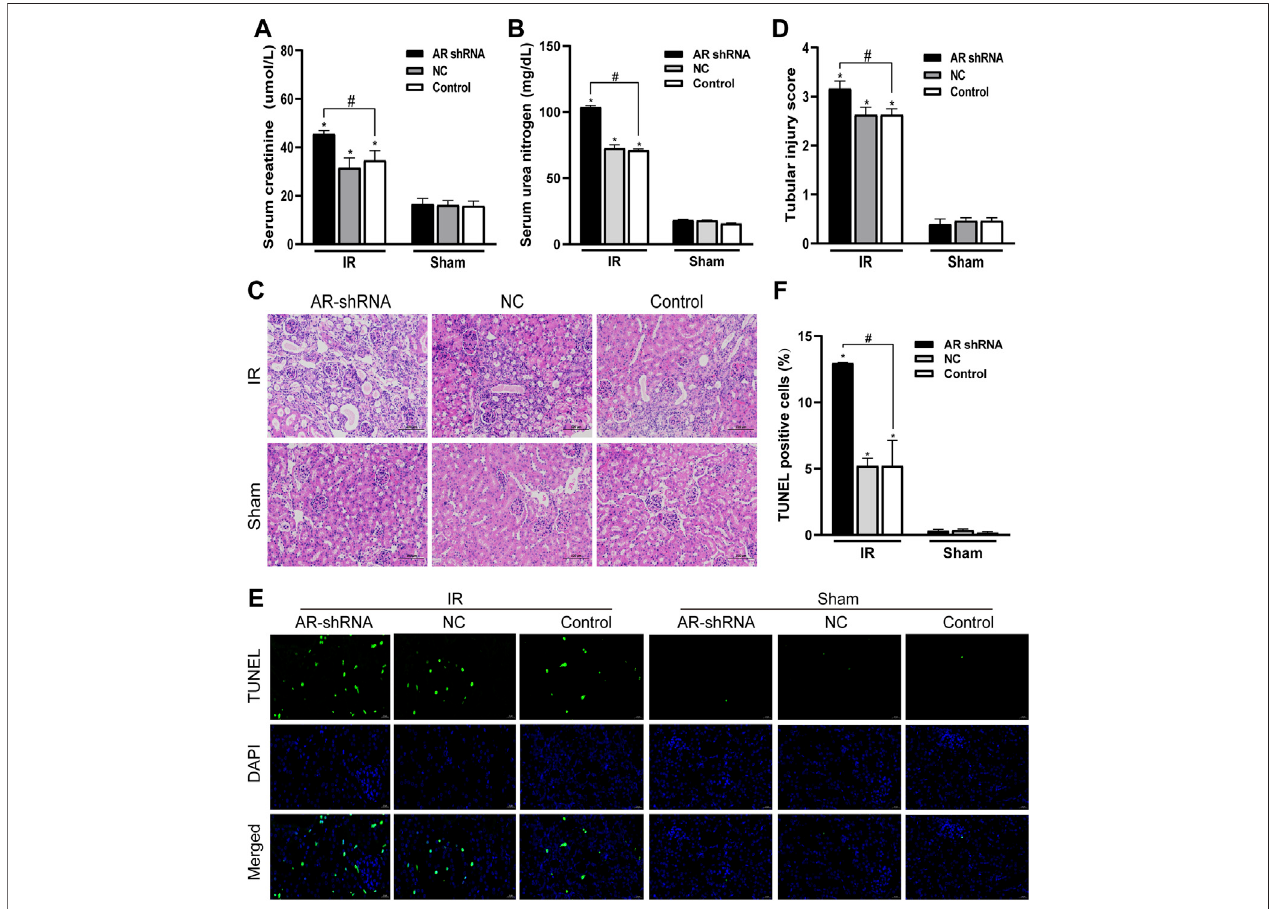
FIGURE 3 | Silencing AR expression aggravates renal ischemia-reperfusion injury in male mice. (A,B) Effects of AR-shRNA silencing AR expression on the level of serum creatinine (A) and serum urea nitrogen (B) in male mice. (C) HE stainingofrenal tissue in each group (original magni fi cation ×200). (D) Correspondingrenal tissue pathologicaldamagescore. (E) RepresentativephotographforTUNELstainingsectionofrenaltubularepithelialcells(green)ineachgroup.Originalmagni fi cation:×400. Scalebar:20 µm. (F) QuantitativeevaluationofTUNEL-positivecellsinrenaltissue.Datadisplayedaremean±SEM( n > 5).Comparedwithshamoperationgroup, * p < 0.05. Compared with Control + IR group, # p <